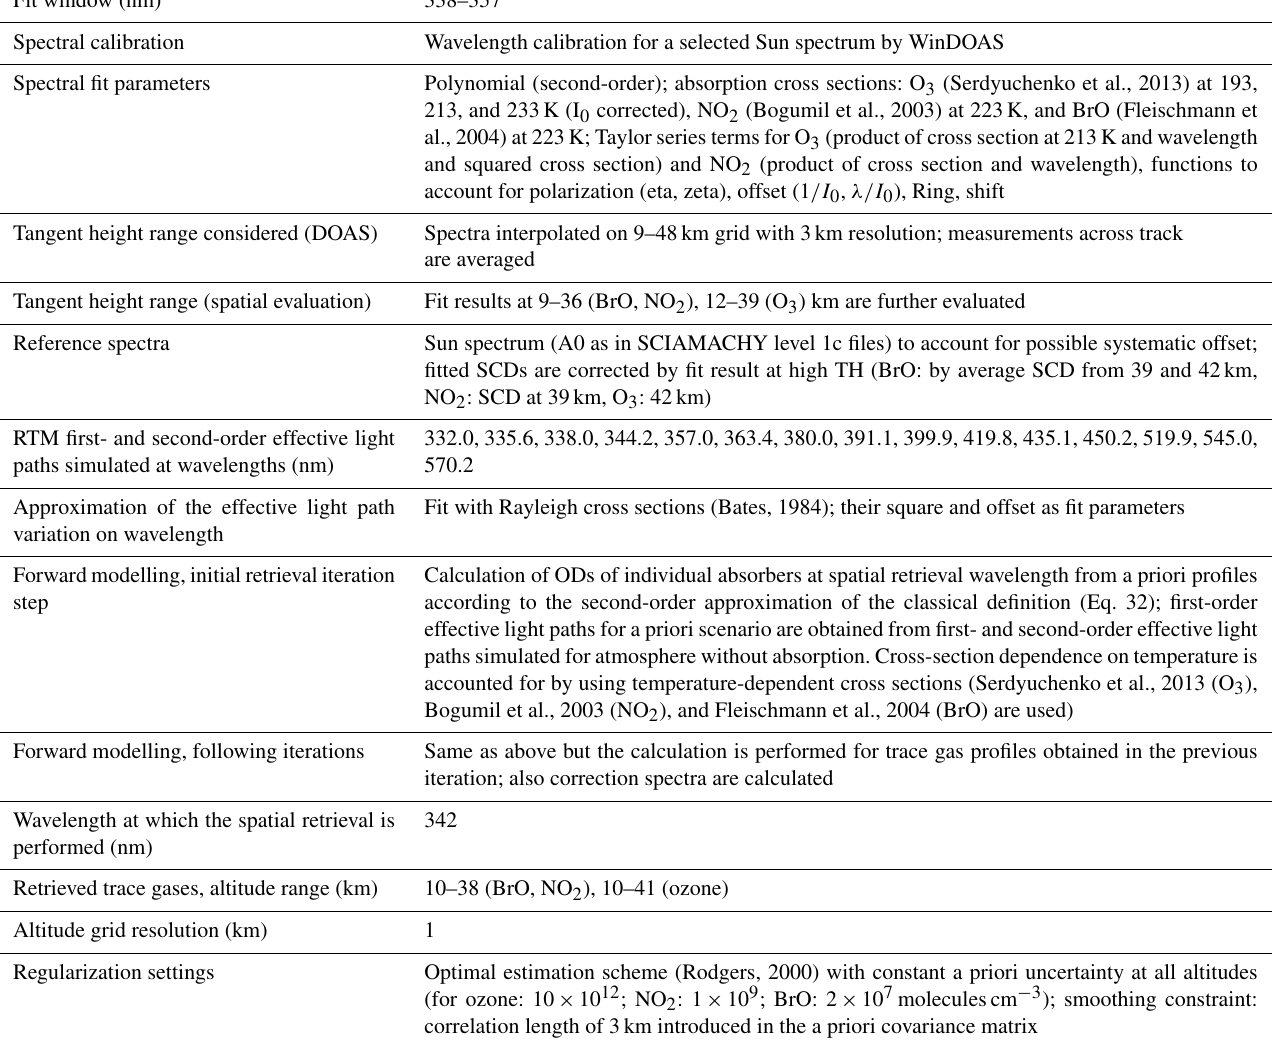
Table 3. Settings of the iterative two-step algorithm for the application to SCIAMACHY limb observations in the UV. Fit window (nm) 338–357 Spectral calibration Wavelength calibration for a selected Sun spectrum by WinDOAS Spectral fit parameters Polynomial (second-order); absorption cross sections: O 3 (Serdyuchenko et al., 2013) at